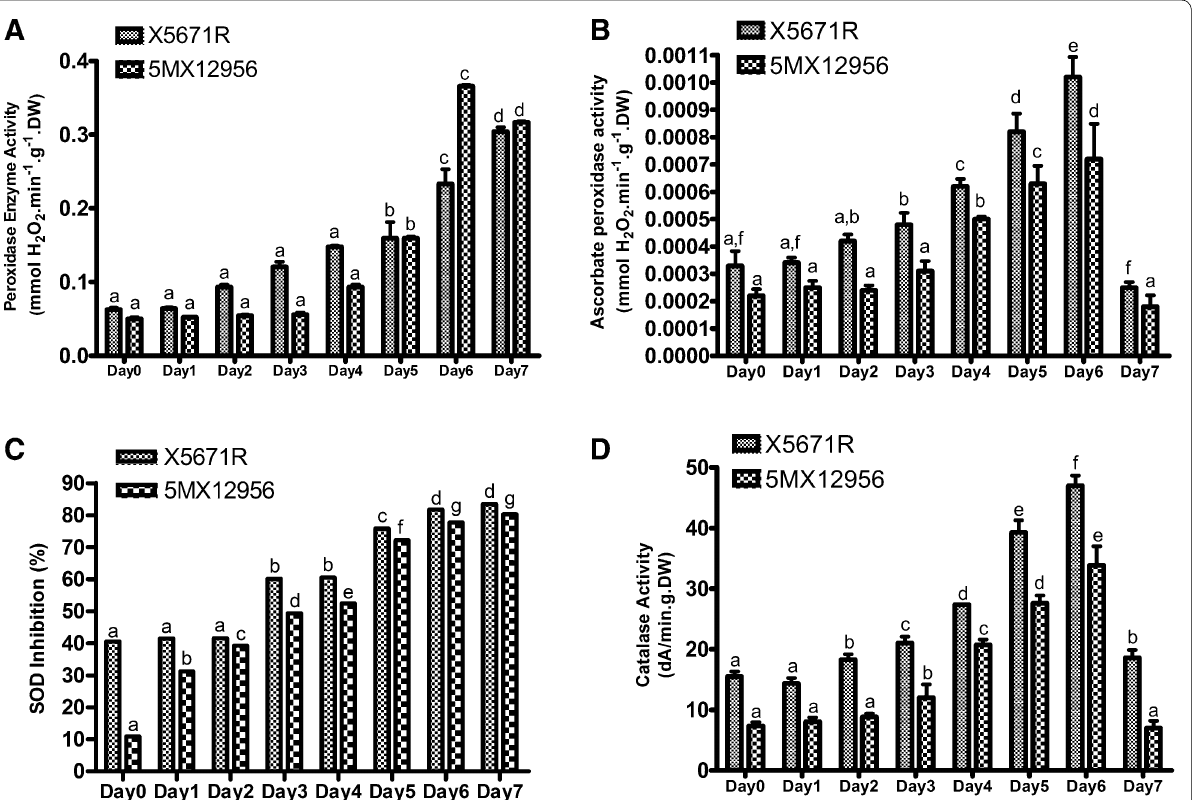
Fig. 3 Effects of 7 day drought stress on the activities of POX ( A ), APX ( B ), SOD ( C ) and CAT ( D ) of X5671R and 5MX12956 tomato seedlings. Data represent the average of three independent experiments with three replicates. Vertical bars indicate sent significance at the 0.05